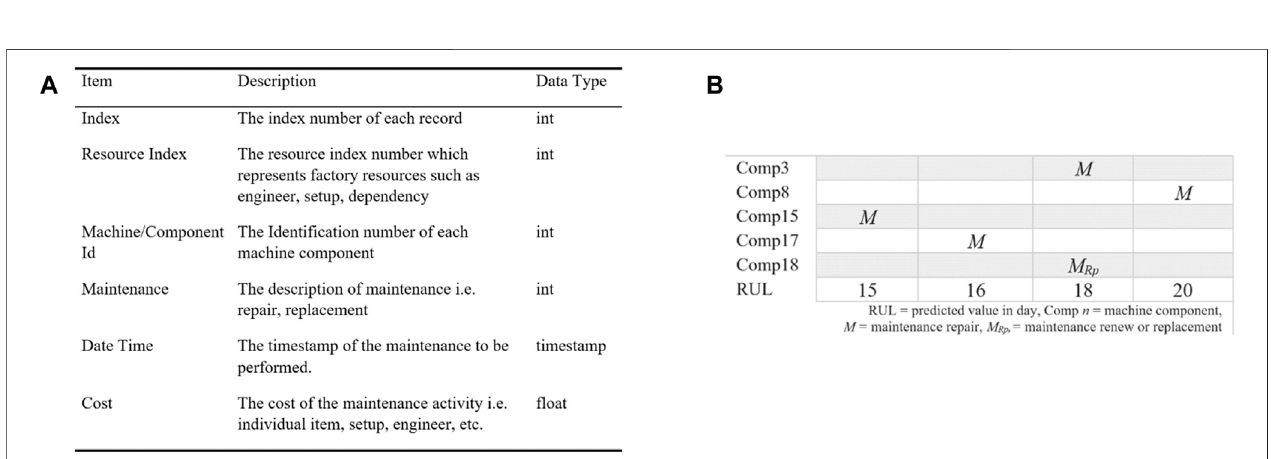
FIGURE 10 | (A) Sample data for the predictive maintenance schedule. (B) Multiple machine components in the product line from FIRST depicting the respective RULs identi fi ed for maintenance analysis.